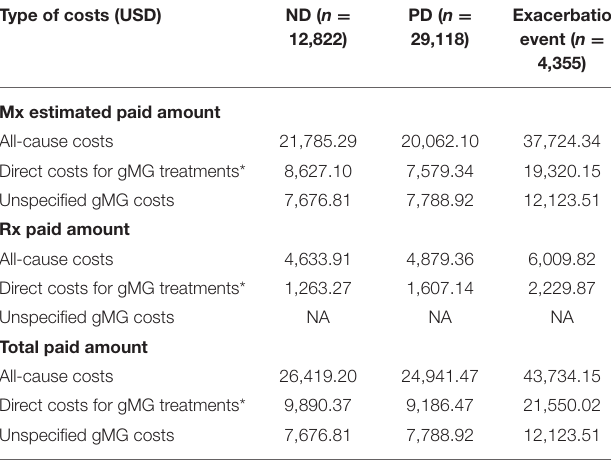
TABLE 7 | Standardized mean 12-month payer-relevant drug costs per patient in ND, PD, and exacerbation event